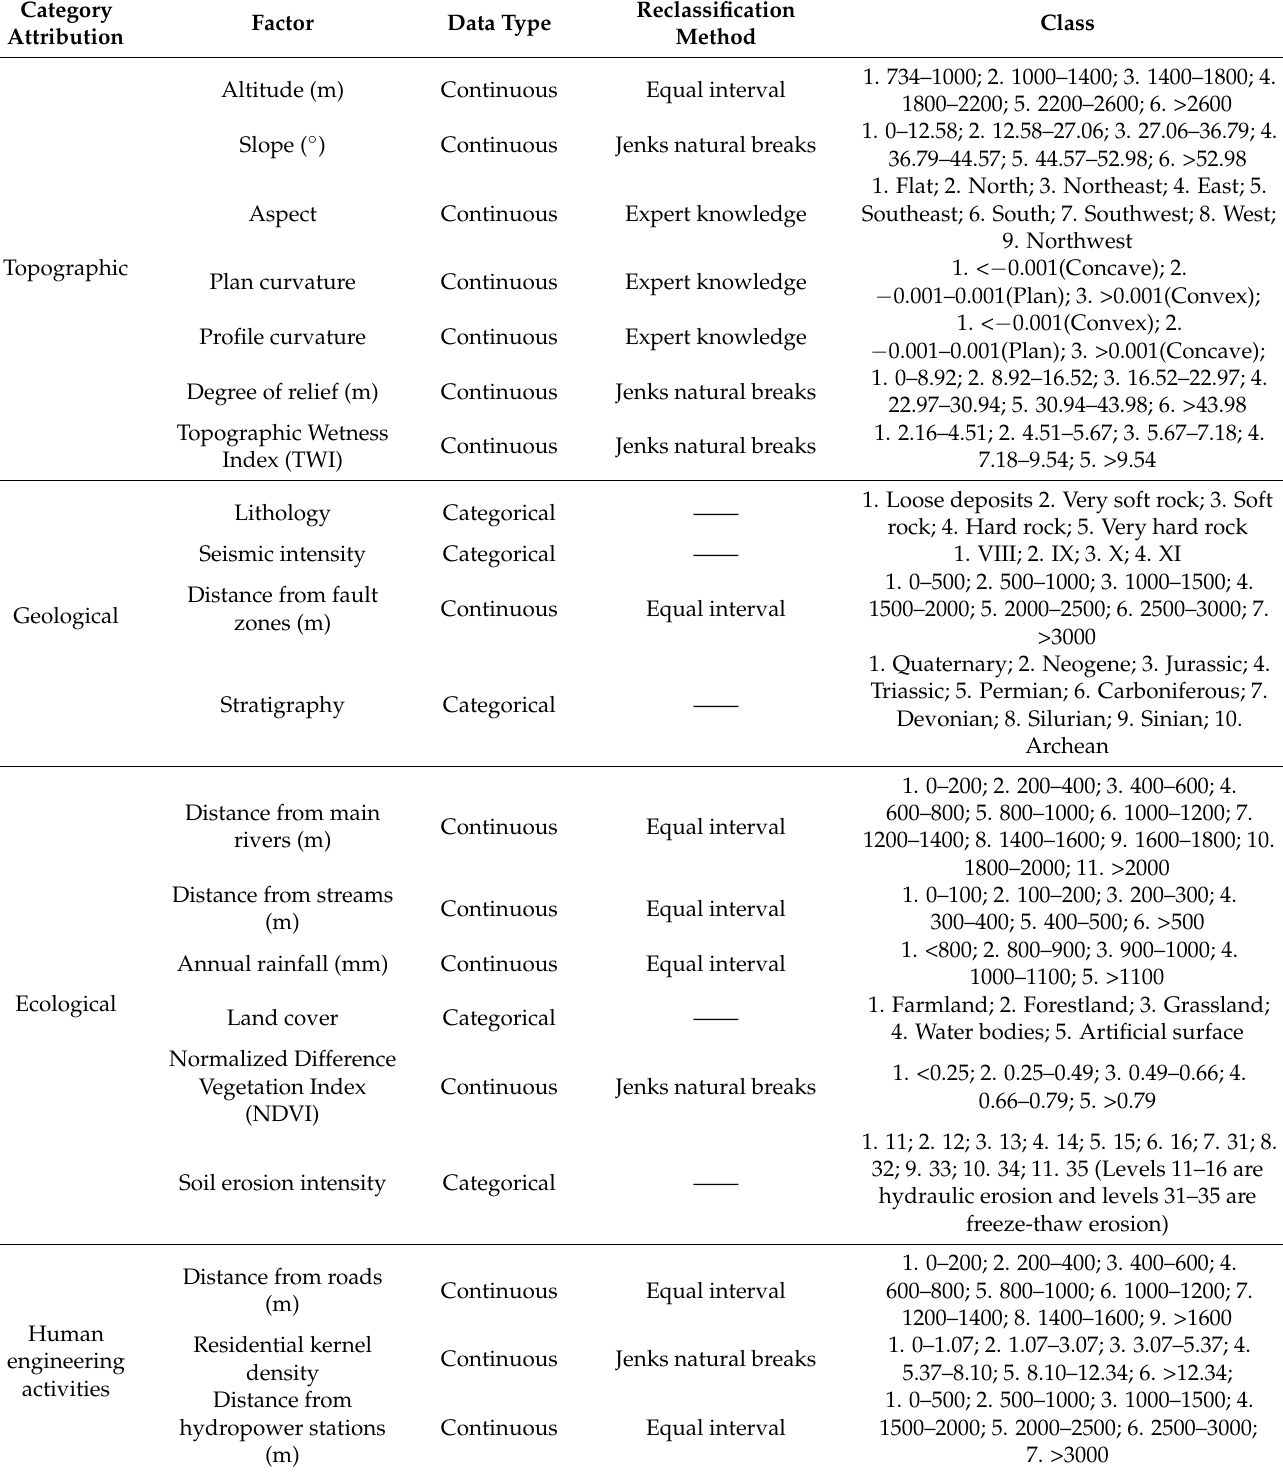
Table 1. Classification of landslide influencing